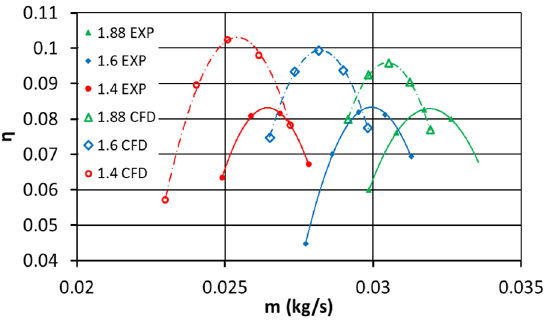
Figure 14. Efficiency as a function of mass flow rate for CFD and experiment.